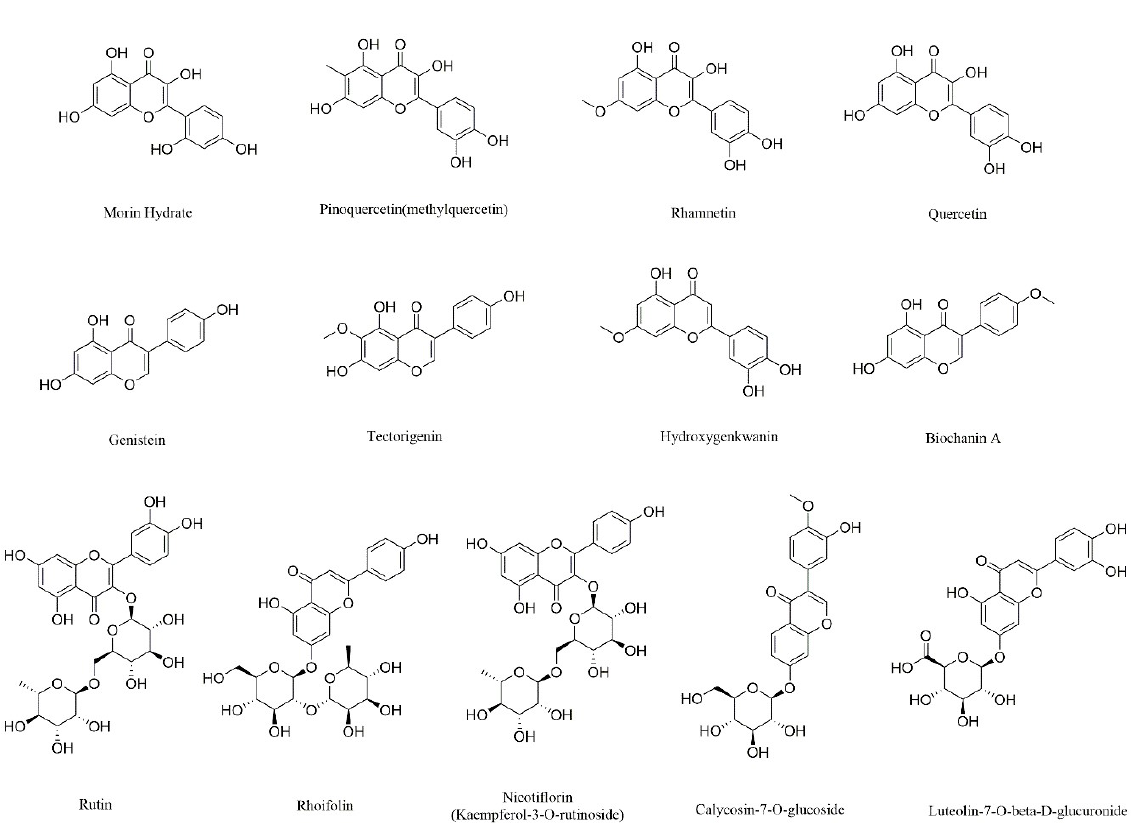
Figure 7. Chemical structural of representative flavonoids and polyphenols bioactive components in WESJ.